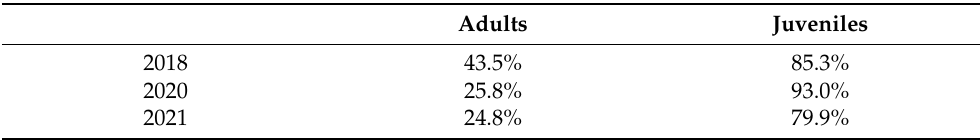
Figure 6. Average daily Varroa destructor mortality in 2021. In the brood cells examined after each heat treatment, a low mortality of adult mites by the adopted combination of time and temperature (Table 1). Table 1. Mortality of adult and juvenile forms of Varroa destructor within brood cells due to heat treatments.